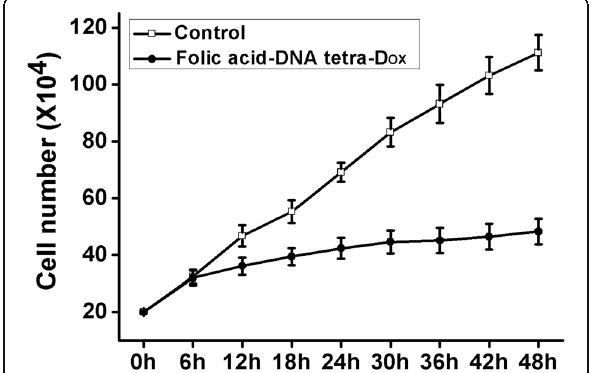
Fig. 6 Inhibition of cell proliferation induced by the incubation with folic acid-DNA tetra-Dox at 100 μ M for different time